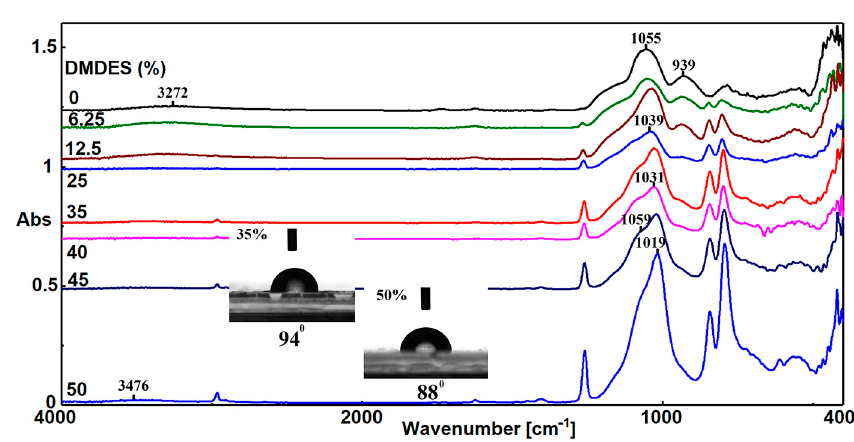
Figure 2. ATR-FTIR spectra and water contact angle of some G5 films obtained at different dimethyldiethoxysilane (DMDES) loadings.